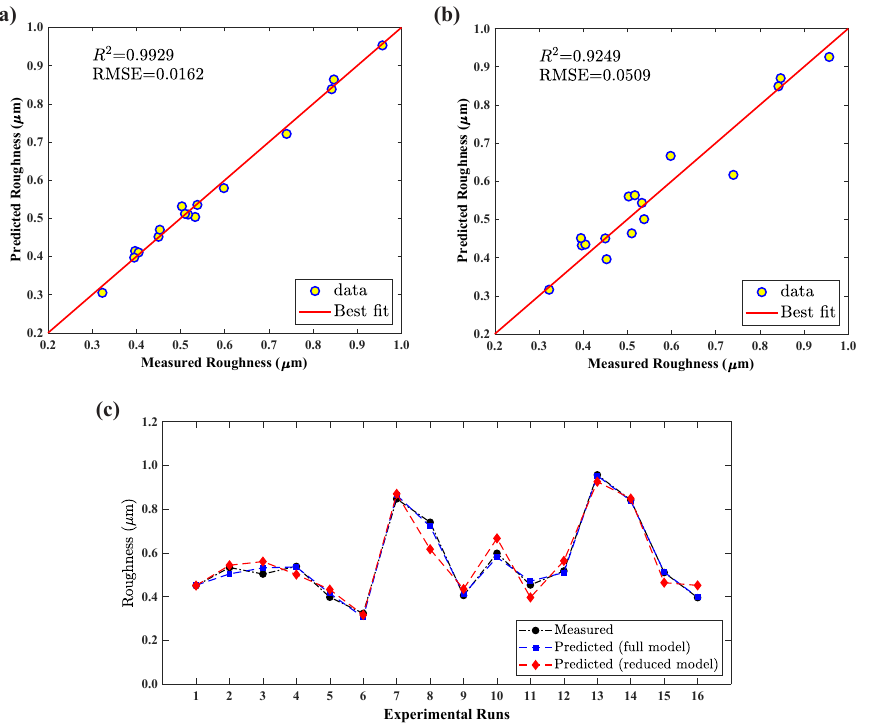
Figure 8. ( a ) Relationship plot of full model; ( b ) relationship plot of reduced model; ( c ) measured vs. predicted data of surface